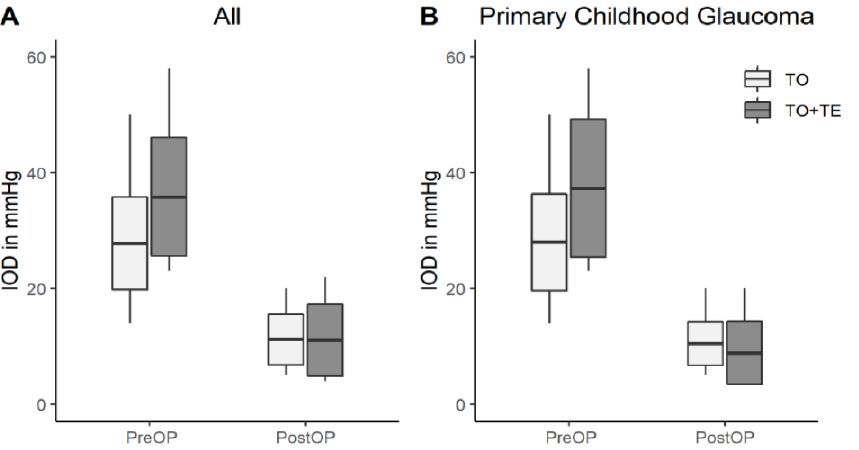
Figure 2. IOP development. IOP values (in mmHg): ( A ) preoperative and postoperative IOP values in all patients (light grey: the metal probe trabeculotomy (TO) group and dark grey: the combined trabeculectomy with trabeculotomy group (TO + TE)) and ( B ) preoperative and postoperative IOP values in the PCG subgroup (light grey: the metal probe trabeculotomy (TO) group and dark grey: the combined trabeculectomy with trabeculotomy group (TO + TE)).